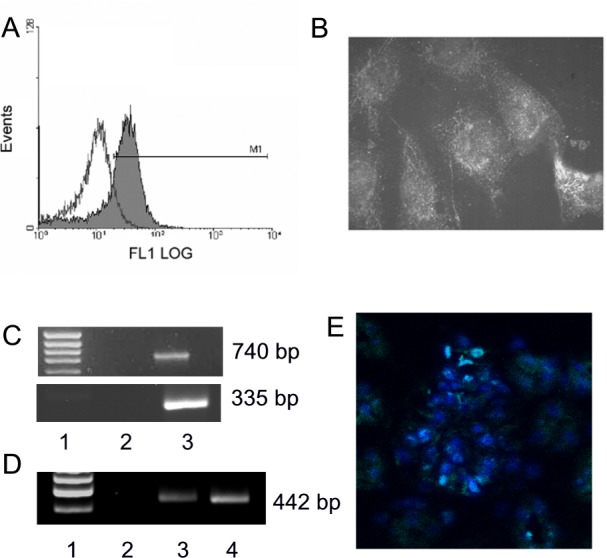
Expression of CD40 in glomeruli and cultured GECs.Panel A. Detection of CD40 by flow cytometry in cultured human GECs. Panel B. Indirect immunofluorescence staining for CD40 in cultured human GECs (x400). Panel C. Representative PCR gels for CD40 expression in cultured human (upper panel) and mouse (lower panel) GECs. Lane 1: 100 bp molecular weight markers; Lane 2: PCR for CD40, no cDNA control; Lane 3: PCR for CD40. Panel D. Representative PCR gels for CD40 expression in primary cultures of rat GECs and rat glomeruli. Lane 1: 100 bp molecular weight markers; Lane 2: PCR for CD40, no cDNA control; Lane 3: PCR for CD40 on primary cultures of rat GECs. Lane 4: PCR for CD40 on rat glomeruli. Panel E. Indirect immunofluorescence staining for CD40 in frozen mouse kidney sections (x63). Images are representative of at least 3 separate experiments with similar results.